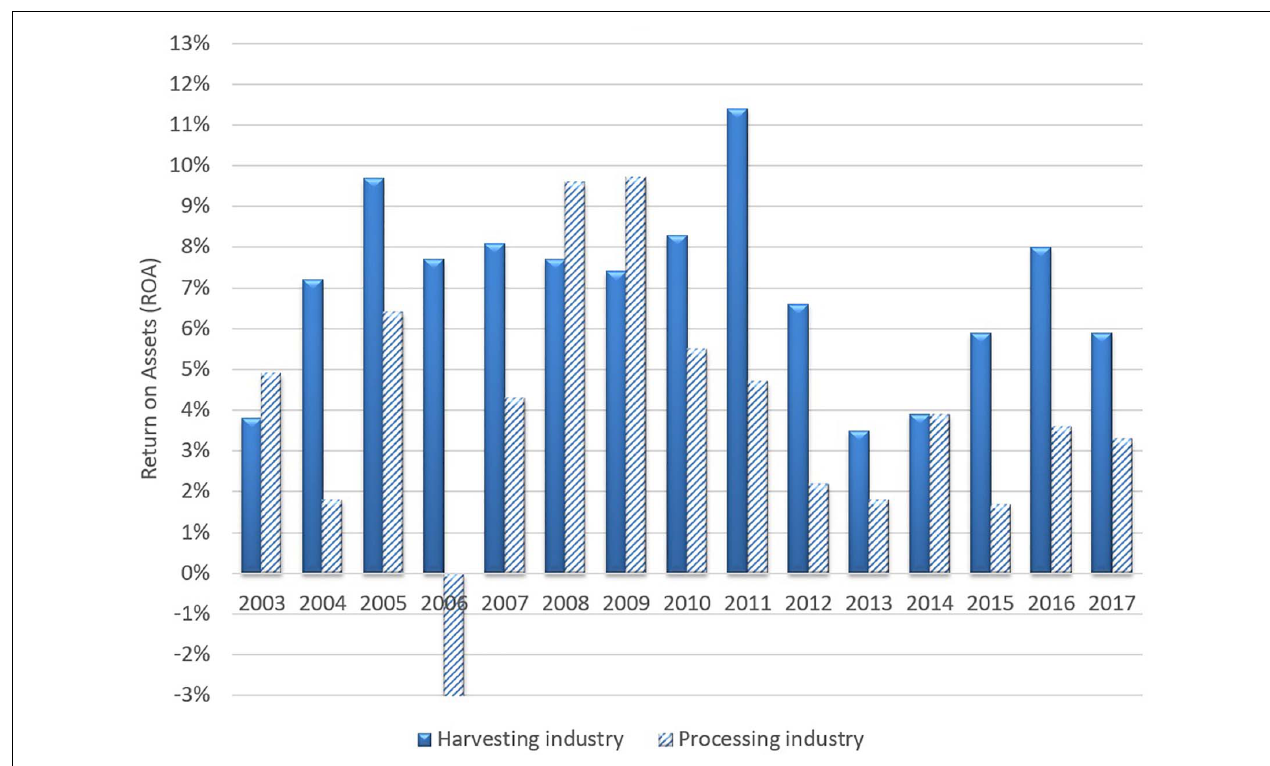
FIGURE 2 | Return on assets (ROA) of the fish harvesting industry and the fish processing industry of the Norwegian pelagic value chain in the period